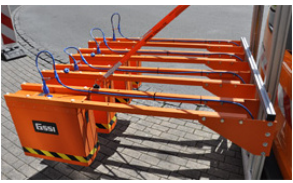
Figure 7. Ground penetrating radar antennas mounted to the measuring